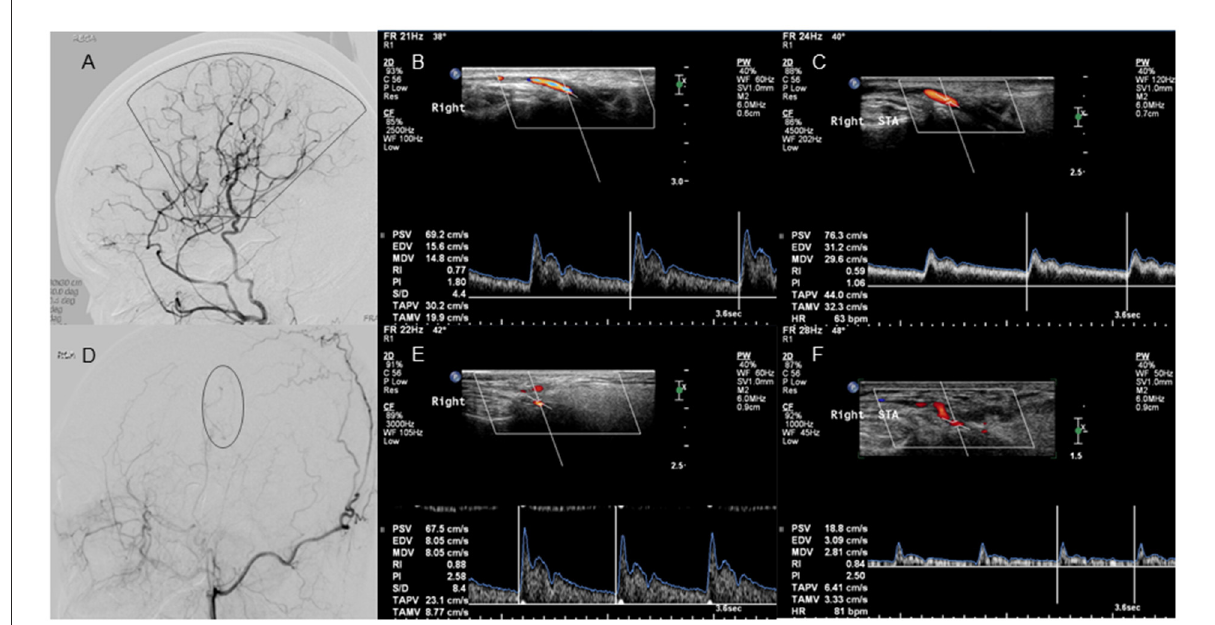
FIGURE4 Lateral projection of ECA angiogram and STA ultrasound images in patients with good and poor collateral development after STA-MCA anastomosis. No. 1 A 37-year-old case with moyamoya disease who presented with decreased visual acuity and right-sided motor weakness. (A) The lateral projection of the ECA angiogram shows that the perfusion range (sector) of STA collateral vessels exceeds 2/3 of the MCA blood supply area in patients with good collateral development after STA-MCA anastomosis. (B) CDU shows the high RI in the STA before STA-MCA anastomosis. (C) CDU shows the low RI with increased EDV in the STA after STA-MCA anastomosis in patients with good collateral development. No. 2A 40-year-old case with moyamoya disease who presented with motor weakness on the right side. (D) The lateral projection of the ECA angiogram shows that the perfusion range (oval) of STA collateral vessels is < 2/3 of the MCA blood supply area in patients with poor collateral development after STA-MCA anastomosis. (E) CDU shows that the STA has a high RI before STA-MCA anastomosis. (F) CDU shows that the STA still has the high RI with low EDV in patients with good collateral development after STA-MCA anastomosis. ECA, external carotid artery; STA, superficial temporal artery; MCA, middle cerebral artery; CDU, color Doppler sonography; RI, resistance index; EDV, end-diastolic